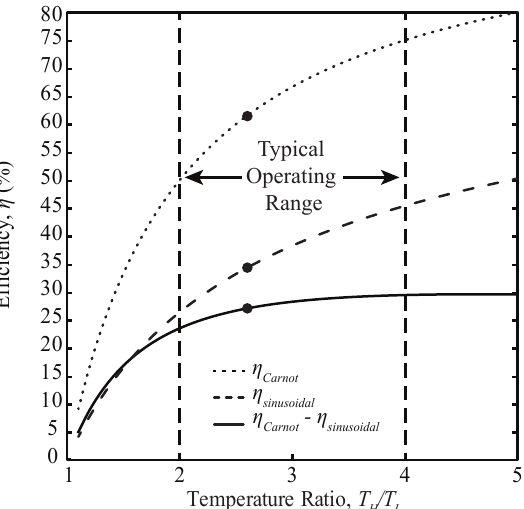
Figure 5. Efficiencies for Carnot, the sinusoidal cycle, and the deviation between them for an alpha-type Stirling engine at various temperature ratios. The points indicate the values for the engine details provided in Table